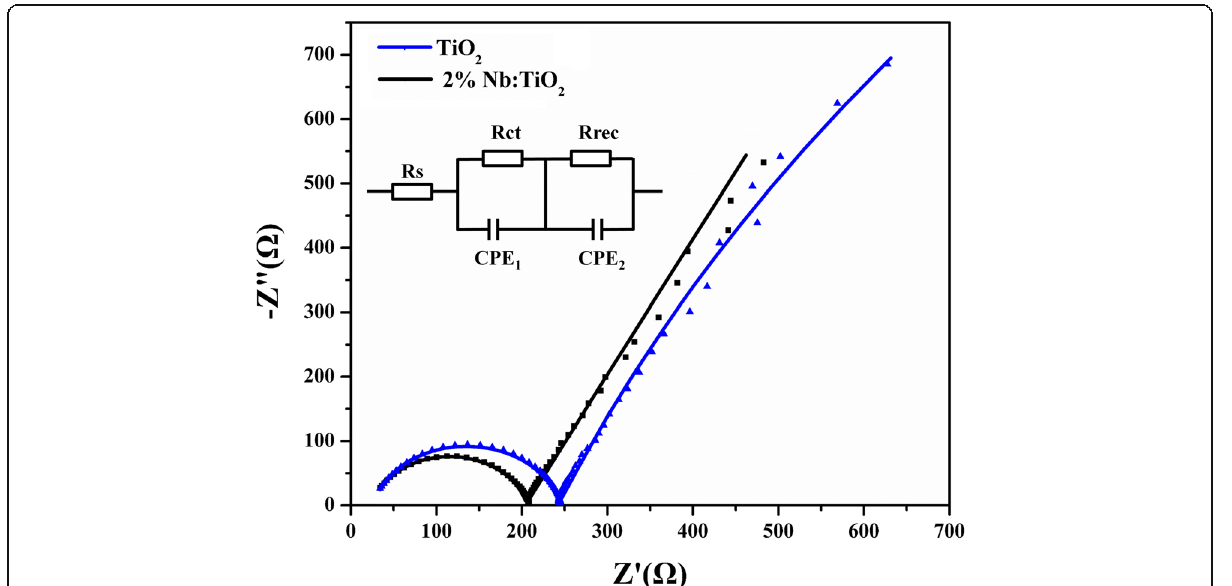
Fig. 5 Nyquist plots of devices based on bare TiO 2 and 2% Nb-doped TiO 2 layers